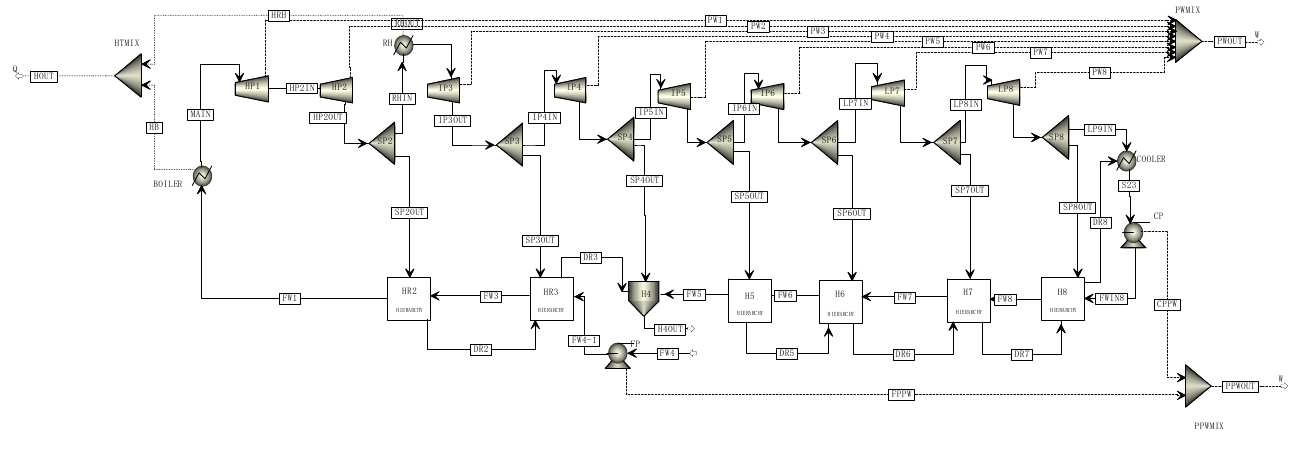
Figure A2. Thermal power units process. Table A5. Models and parameters adopted in the thermal power unit simulation process.